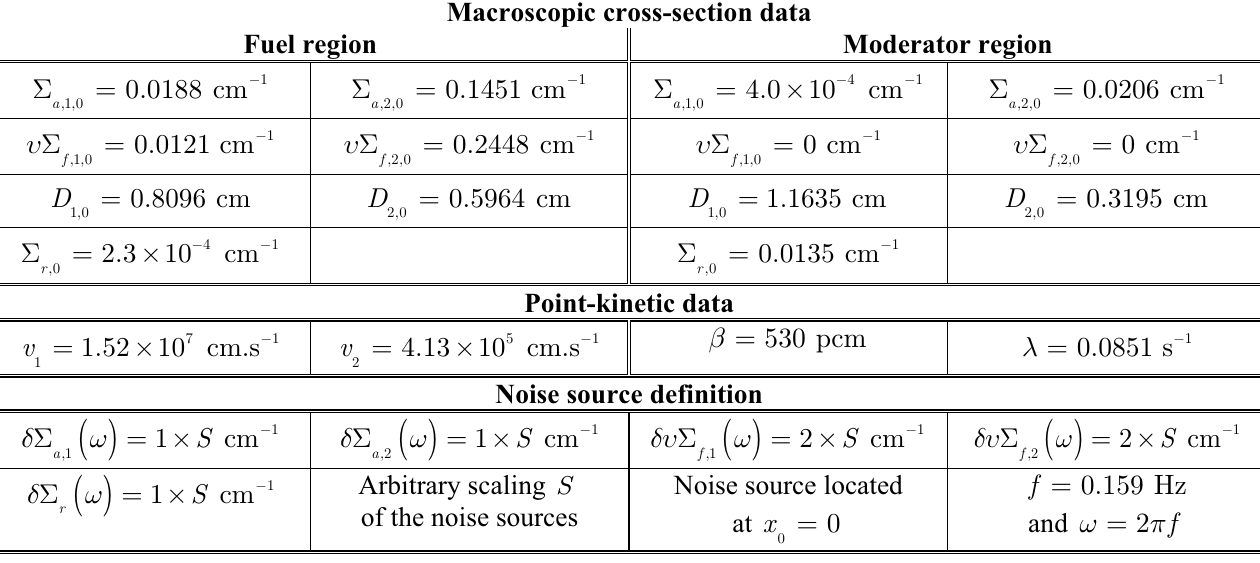
Fig. 3 Representation of the heterogeneous test case. Table 2. Definition of the heterogeneous test